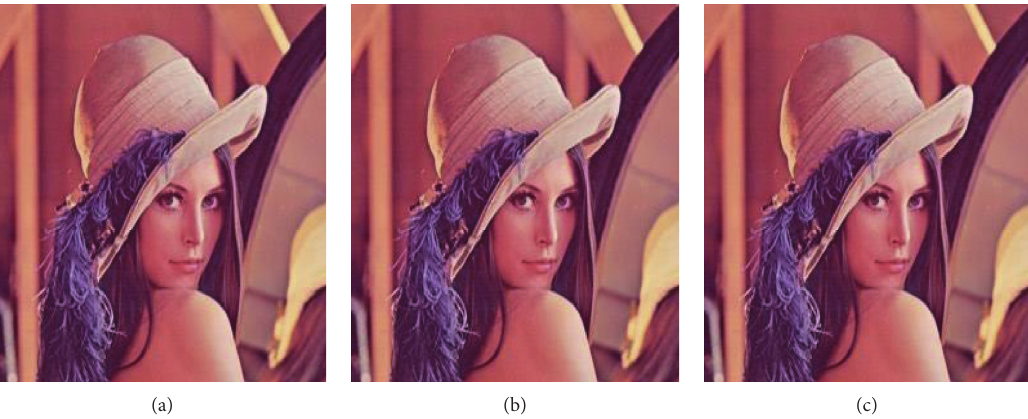
Figure 13: The decrypted images. (a) Decrypted image (vs. the inverse process in Figure 10) (b) Decrypted image (vs. the inverse process in Figure 11) (c) Decrypted image (vs. the inverse process in Figure